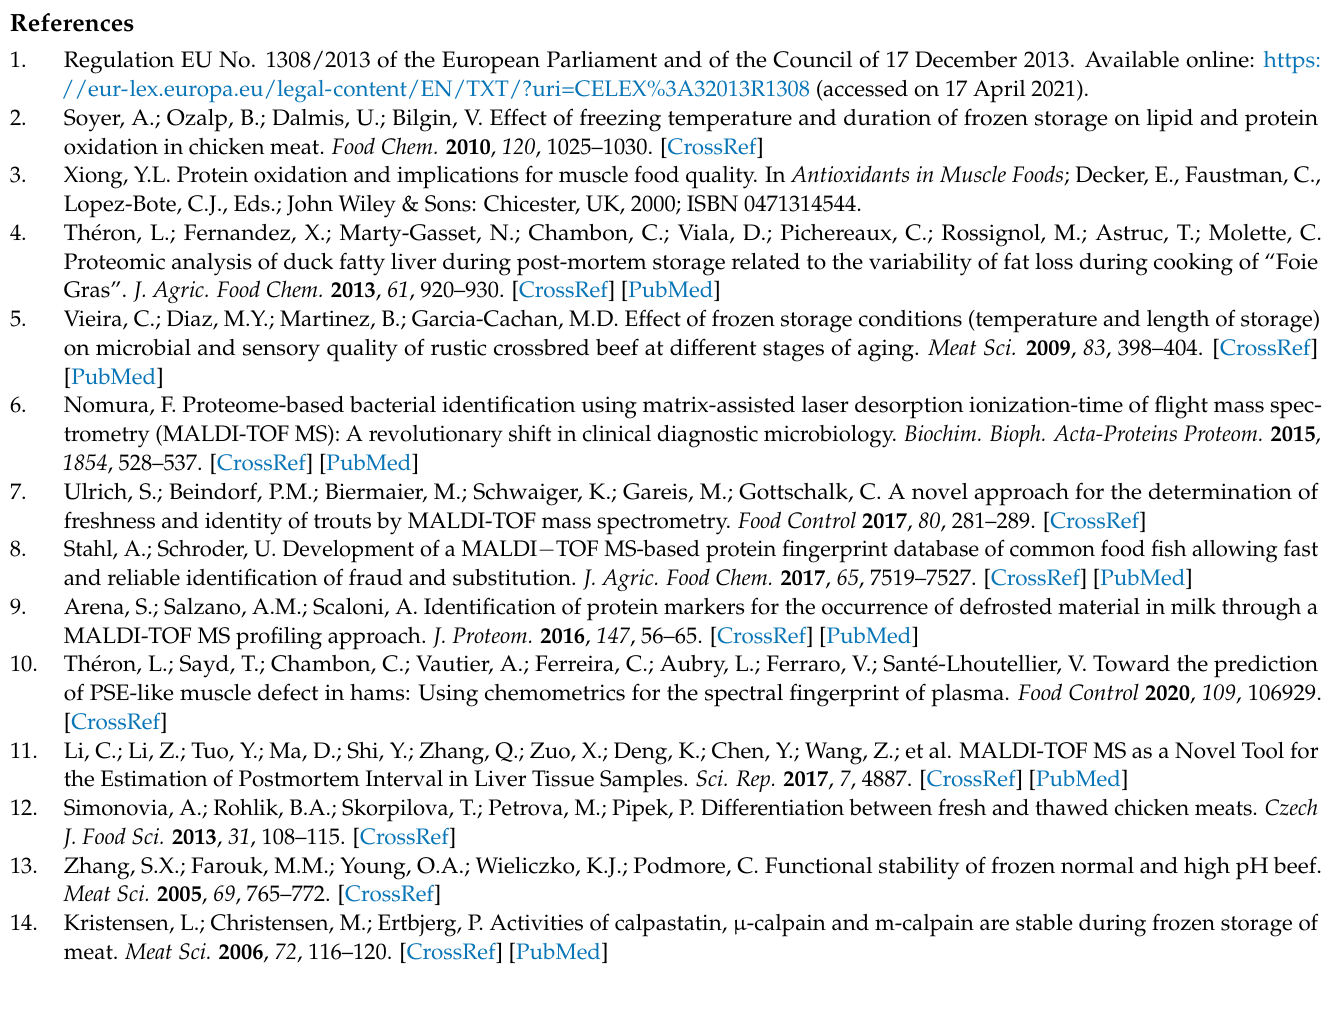
Supplementary Materials: Table S1: List of peaks detected in fresh and frozen-thawed